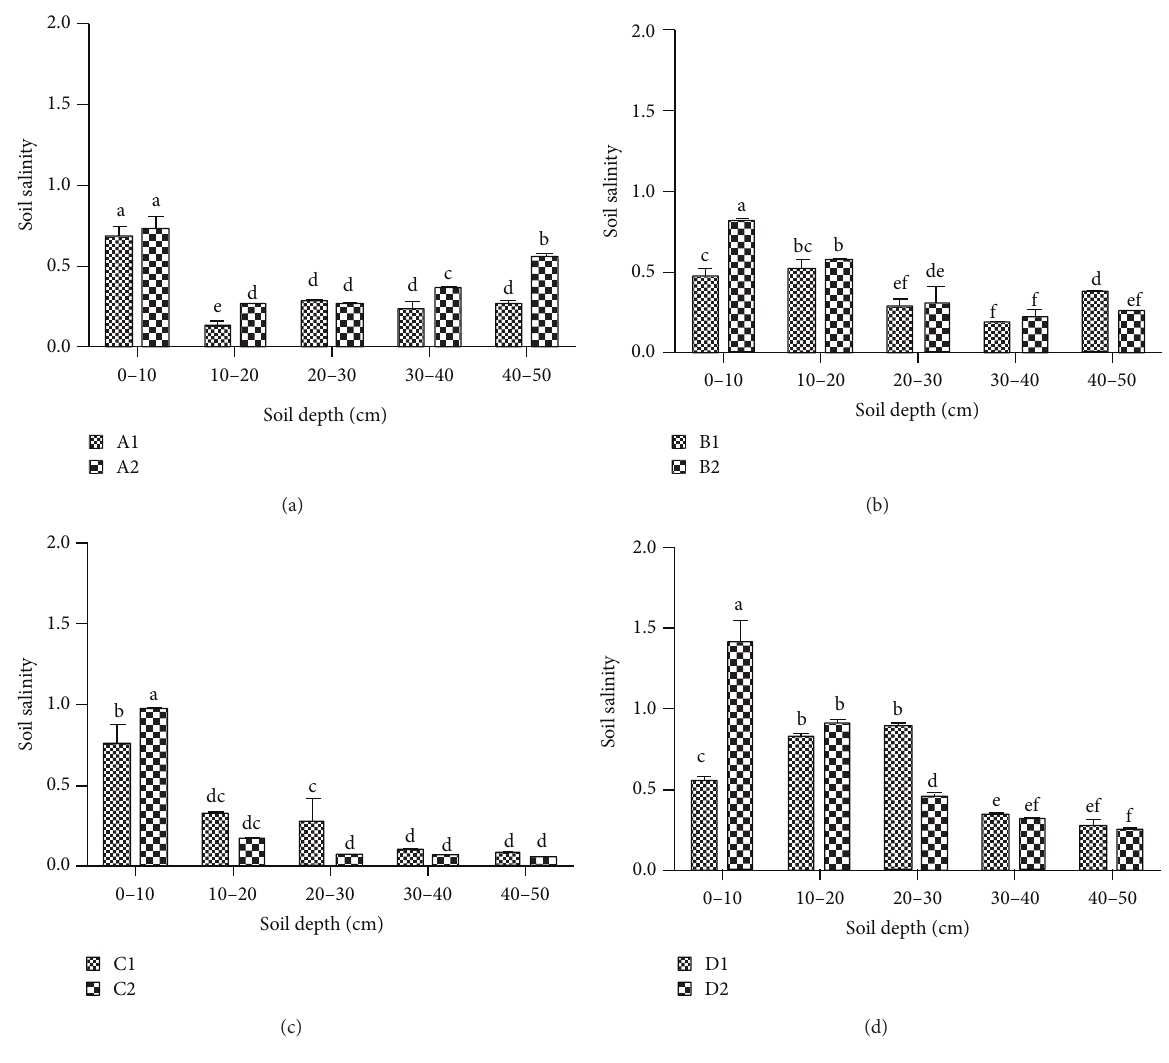
Figure 4: Spatial distribution of soil